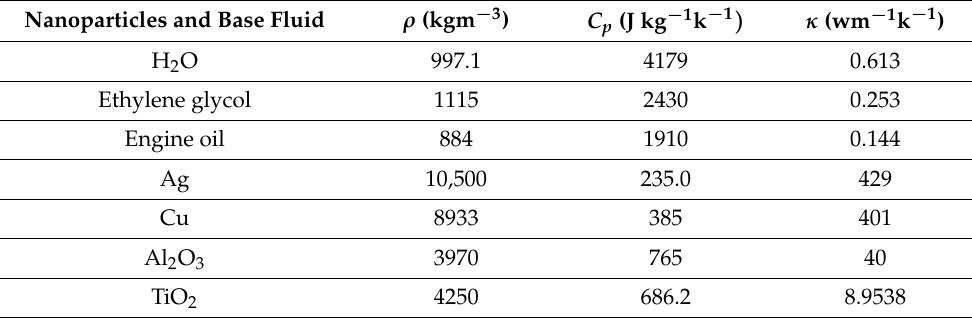
Table 2. Different base fluids’ and nanoparticles’ thermophysical properties (Sheikholeslami and Ganji